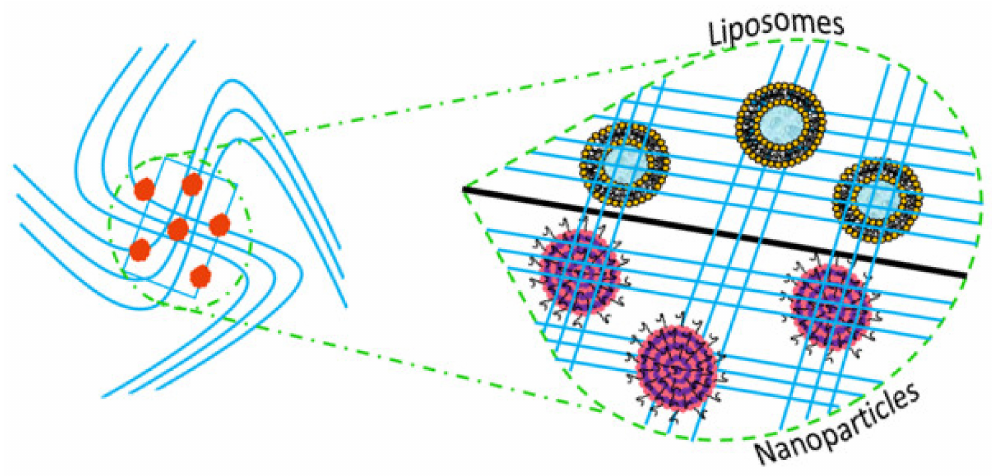
Figure 3. Schematic representation of composite scaffolds, made up of nanosystems embedded into three-dimensional (3D)